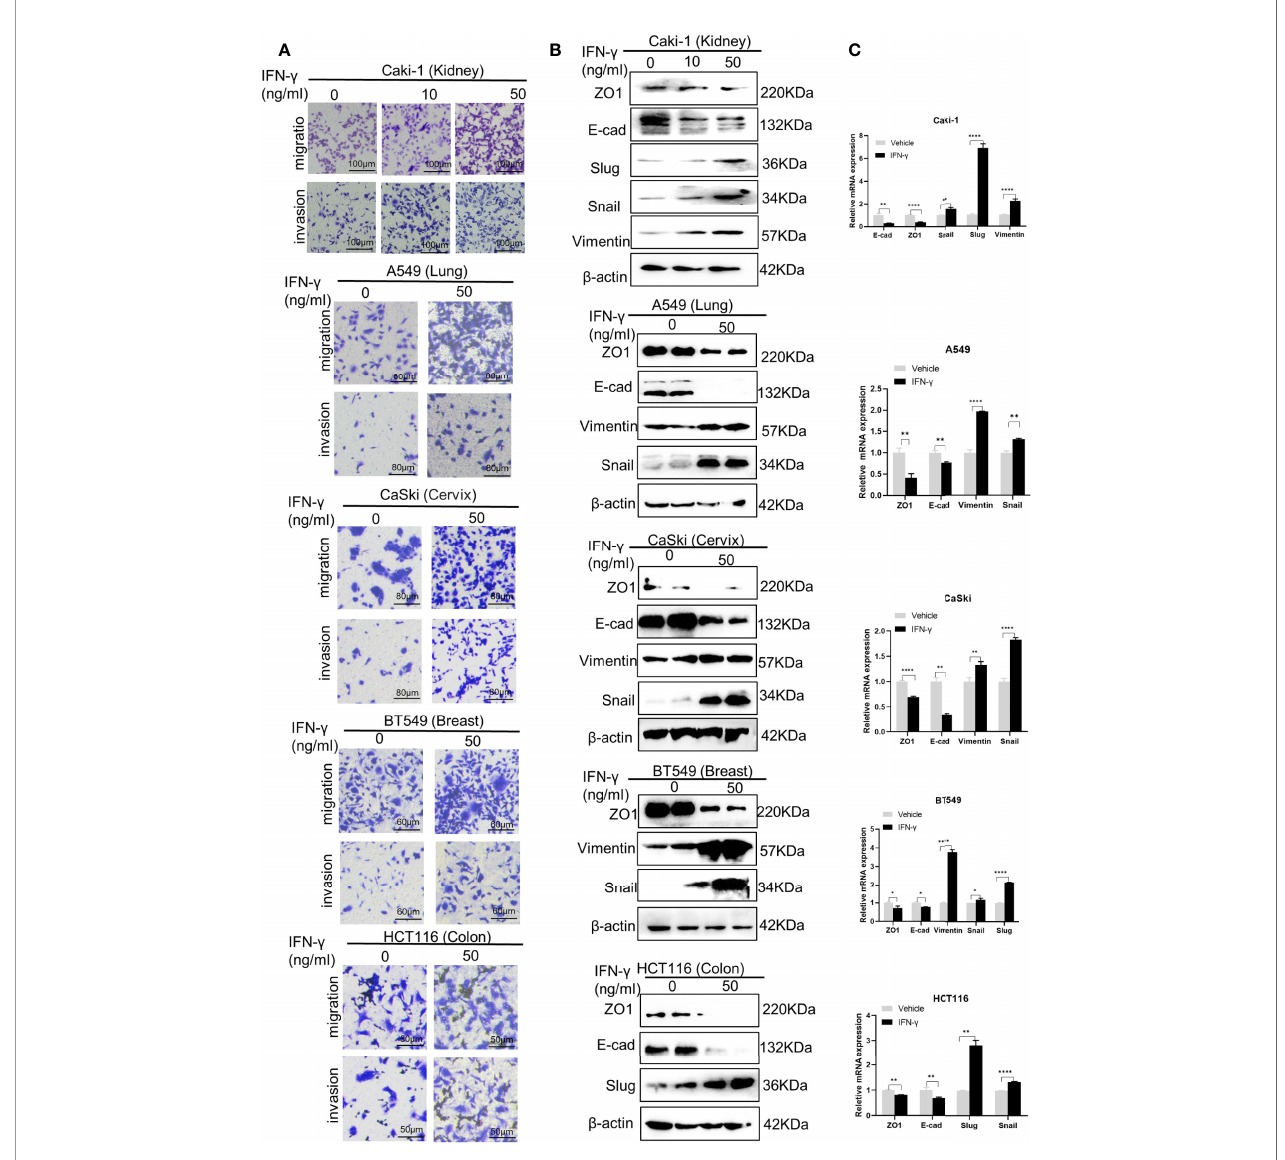
FIGURE 1 | IFN- g treatment enhances epithelial-mesenchymal transition (EMT) and metastasis in various tumors. (A) Transwell assays to detect the migration and invasion abilities of different cancer cell lines without and with IFN- g treatment (50 ng/ml, 48 h). (B) Western blotting assays to examine the effect of IFN- g treatment (50 ng/ml, 48 h) on expression of EMT markers at the protein level. (C) RT-qPCR assays to detect the changes in expression of EMT markers at the mRNA level after IFN- g treatment (50 ng/ml, 48 h). Data are shown as the mean ± standard deviation (SD). *P < 0.05, **P < 0.01, ****P <